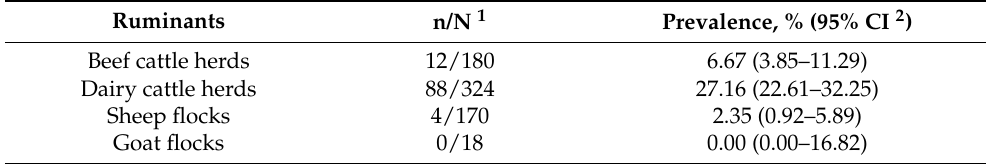
Table 1. Prevalence of Coxiella burnetii antibody-positive herds among beef and dairy herds and sheep and goat flocks sampled for national surveillance programs in Estonia during 2012–2013. Ruminants